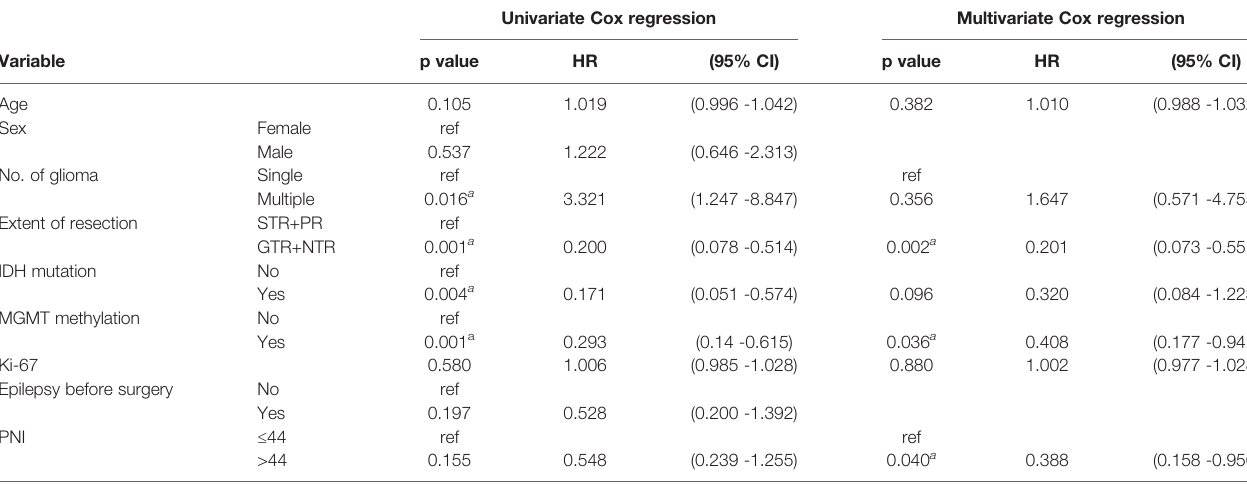
TABLE 2 | Univariate and multivariate Cox regression analyses for overall survival in grade IV glioma patients. Univariate Cox regression Multivariate Cox regression